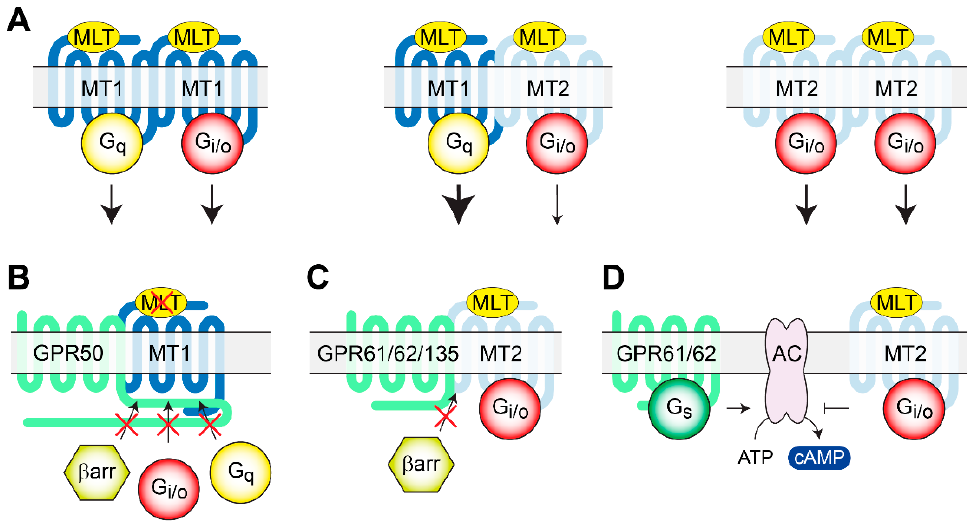
Figure 2. Heteromerization of melatonin receptors and oGPCRs. ( A ) MLT activation of homo- and heteromers of MT1 and MT2 receptors triggering Gi / o and Gq signaling pathways. ( B ) Heteromerization of MT1 with GPR50 inhibits melatonin binding to MT1 and recruitment of signaling molecules. ( C ) Similarly, MT2 heteromerization with GPR61, GPR62, or GPR135 inhibits β -arrestin recruitment but does not affect MLT binding, nor G protein activation. ( D ) The constitutive Gs signaling of GPR61 and GPR62 counteracts MT2 receptor Gi // o signaling, modulating intracellular cAMP levels. AC, Adenylate Cyclase; β arr, β arrestin; MLT, melatonin; MT1, melatonin receptor 1; MT2, melatonin receptor 2.